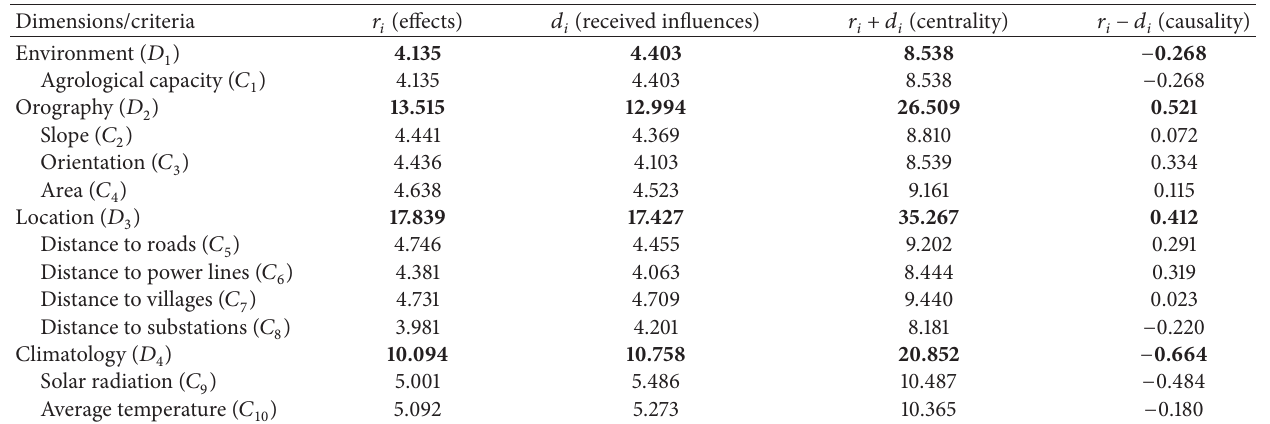
Table 4: The sums of giving and received